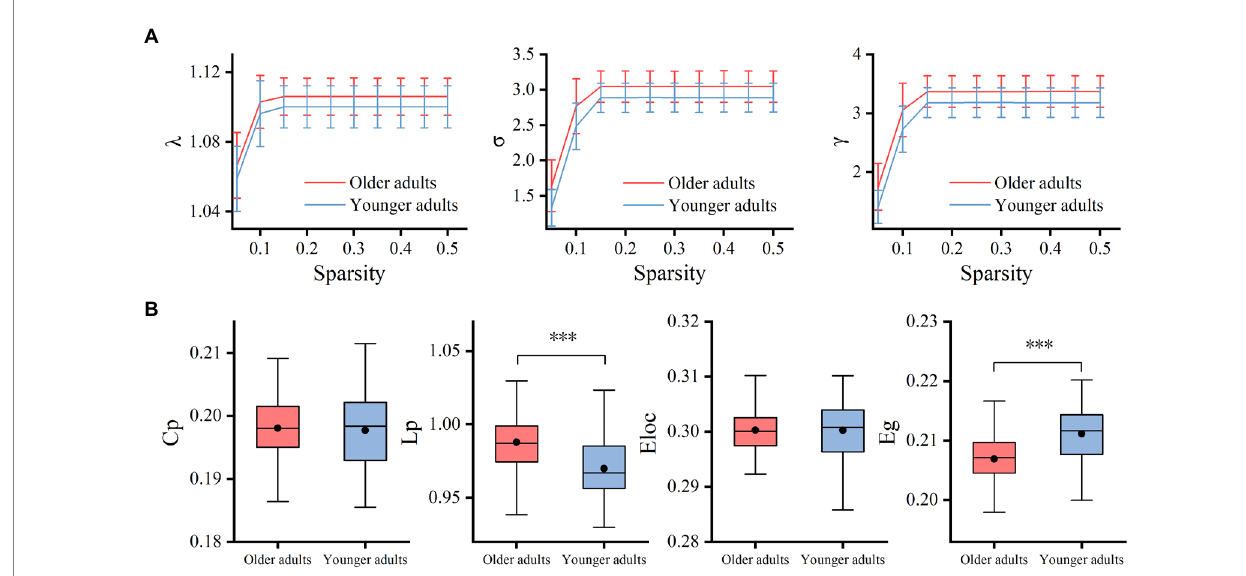
FIGURE 5 Group differences between small-world properties ( λ , σ , γ ) and global topological properties (Lp, Cp, Eloc, and Eg) of the WM network. 𝜆 ≈ 1 and γ > > 1 indicated both the older and younger adults exhibited economic “small-world” properties (A) . The older adults showed increased Lp and decreased Eg compared to younger adults. There was no significant difference in Cp and Eloc between the two groups (B) . Cp, the global clustering coefficient; Lp, characteristic path length; Eg, global efficiency; Eloc, local efficiency; λ , normalized path length; γ , normalized clustering coefficient; σ , small- worldness, ***p < 0.001.